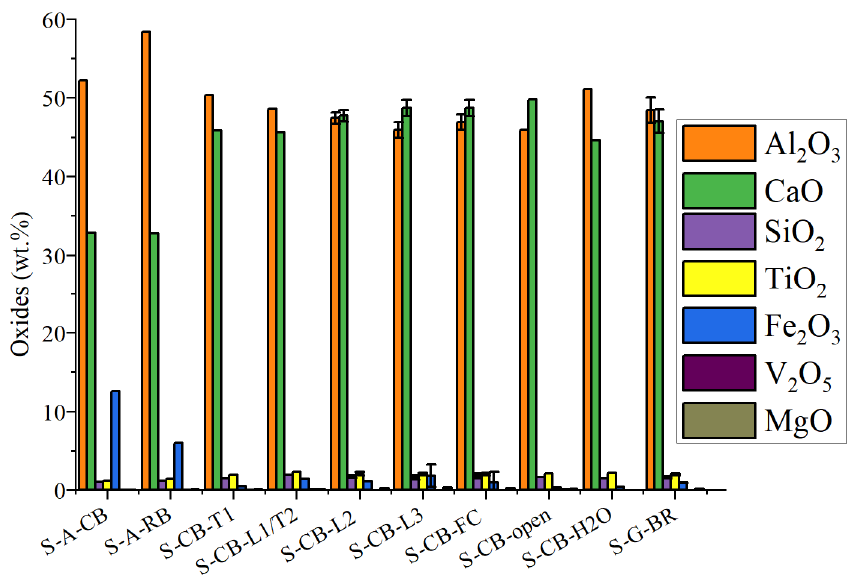
Figure 7. XRF analysis of slags, error bars according to repeated experiments. Holding Time